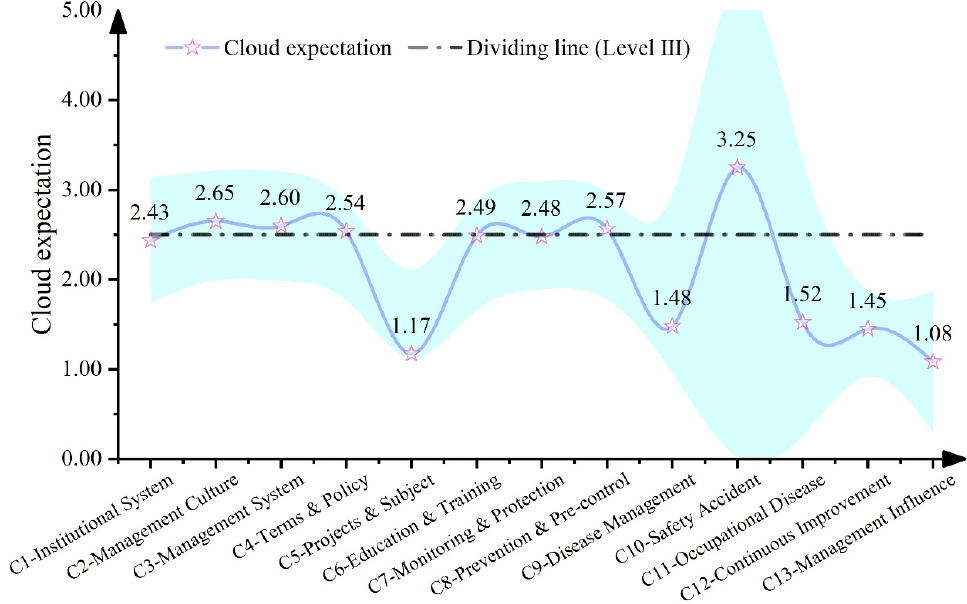
Figure 5. Expected value distribution of the cloud model for element layer indicators.